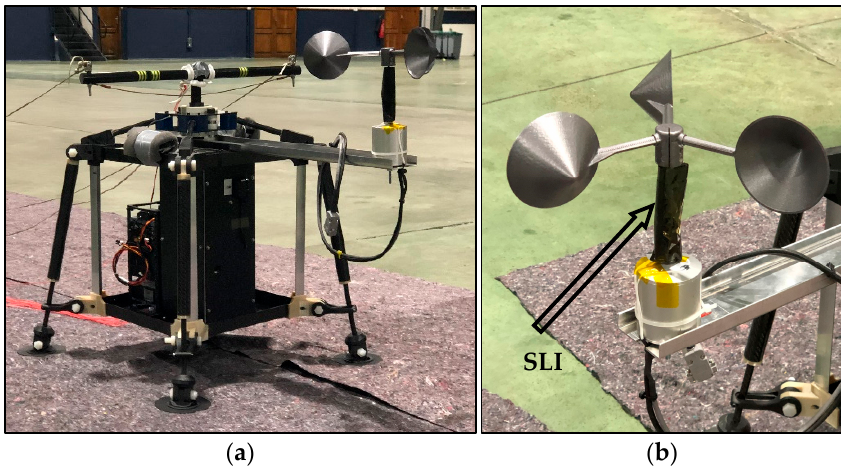
Figure 4. ( a ) Anemometer located on the upper side of the gondola; ( b ) SLI (Single-Layer Insulation) at the neck of the cup anemometer.